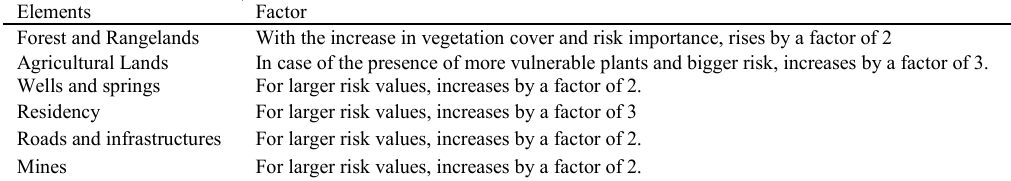
Table 4: Characteristics of the elements at risk (Arami, 2012)